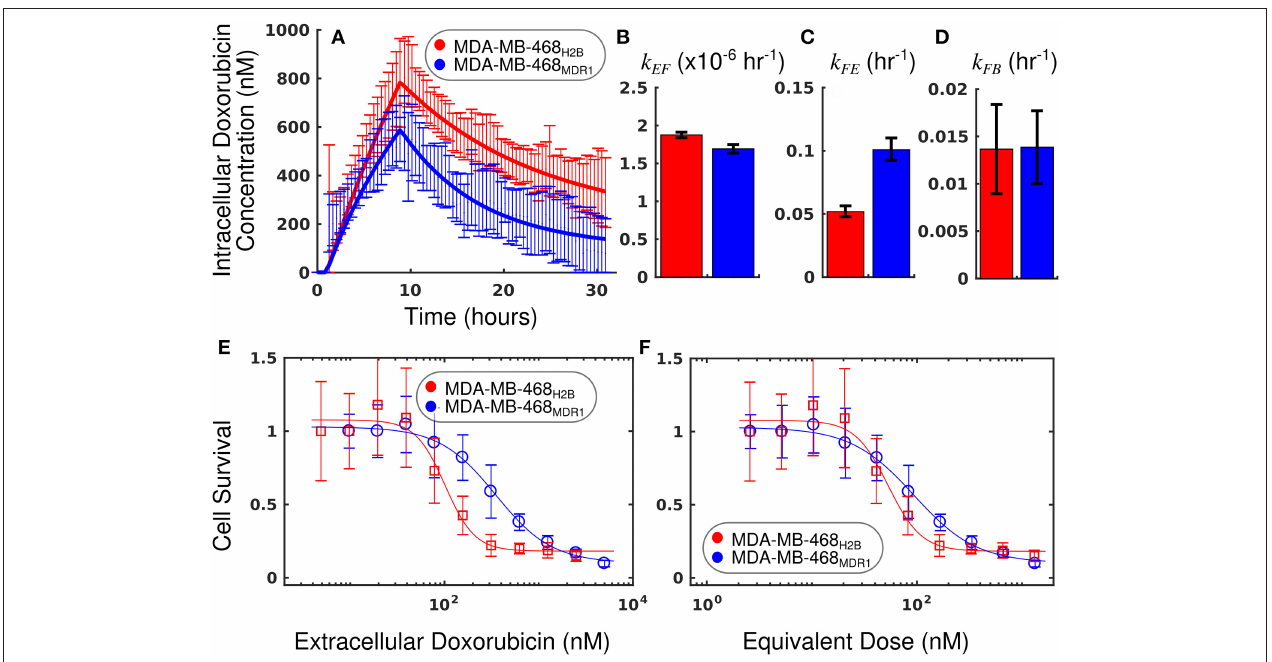
FIGURE 7 | Comparison of MDA-MB-468 H2B and MDA-MB-468 MDR1 cell lines using equivalent dose. The intracellular doxorubicin concentration with 95% CI for each cell line is shown in (A) . The MDA-MB-468 H2B line demonstrates increased intracellular accumulation of doxorubicin relative to the MDA-MB-468 MDR1 line. Equations (1–3) are fit to the doxorubicin uptake data, and the best-fit models are overlaid on the data in a (smooth line). The corresponding parameters with 95% CI are shown in (B–D) . The MDA-MB-468 H2B data are shown in red, and the MDA-MB-468 MDR1 data are shown in blue. Notably, the efflux of drug from the MDA-MB-468 MDR1 ( k FE ) line is significantly greater than the corresponding rate in the MDA-MB-468 H2B line ( p < 0.05). Treatment response is traditionally summarized by cell survival and plotted against applied drug concentration. The cell count relative to control for each cell line is shown as a function of extracellular doxorubicin concentration and equivalent dose in (E,F) , respectively. While a significant difference is observed when comparing these cell lines via EC 50 calculated with the extracellular doxorubicin concentration, no significant difference is observed when comparing the EC 50 statistic derived from the equivalent dose. The equivalent dose can account for the differing pharmacokinetic properties to reveal similar doxorubicin pharmacodynamics in these cell